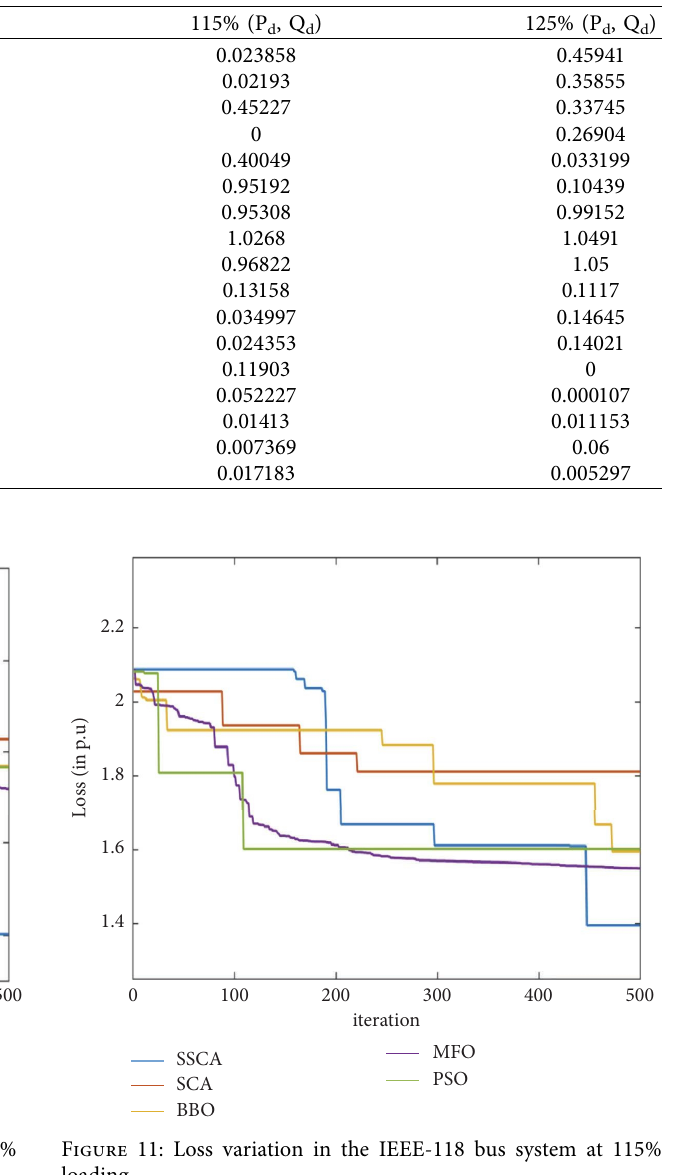
Table 12: Optimal Control Variable at various loading of IEEE 30 bus system.